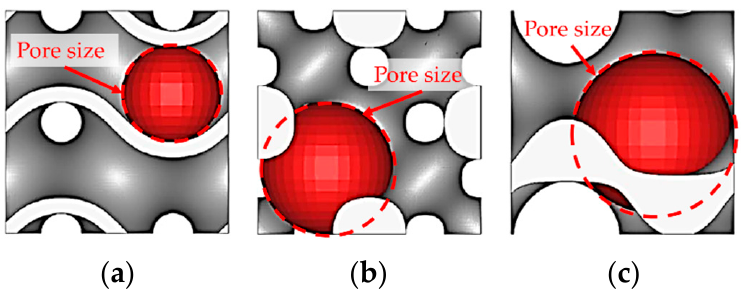
Figure 8. The maximum sphere, passing through the smallest hole of different TPMS topologies [53]: ( a ) Sheet-Gyroid; ( b ) Solid-Diamond; ( c ) Solid-Gyroid structures.